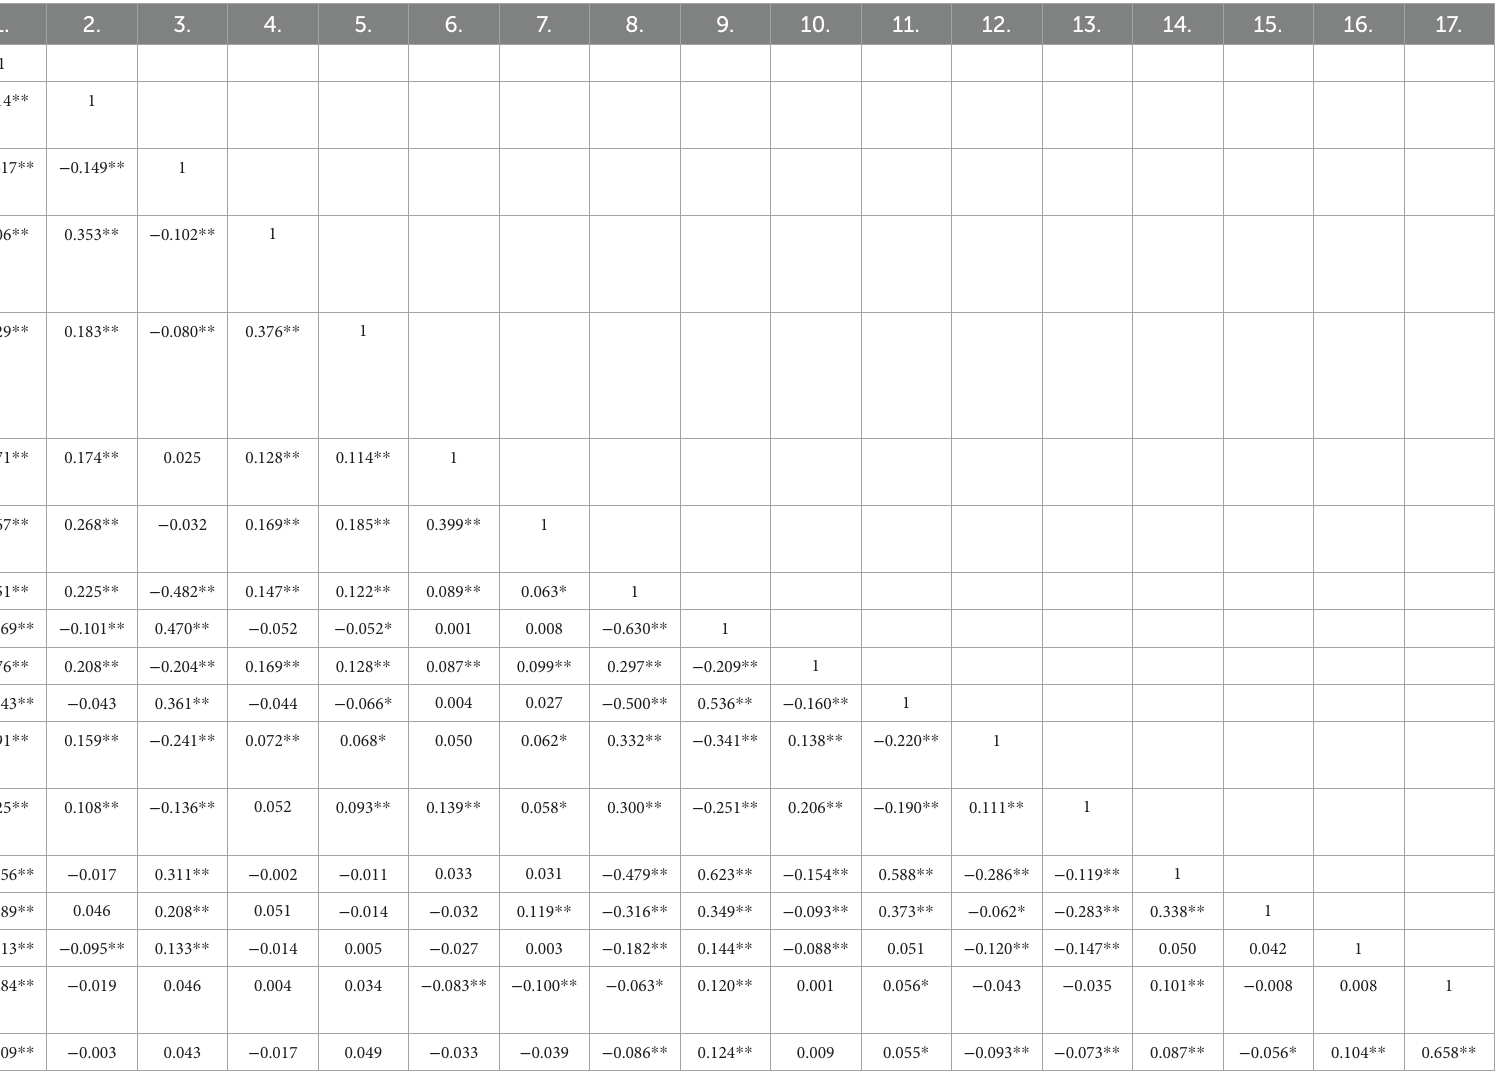
TABLE 2 Correlations table of all the variables included in the regression